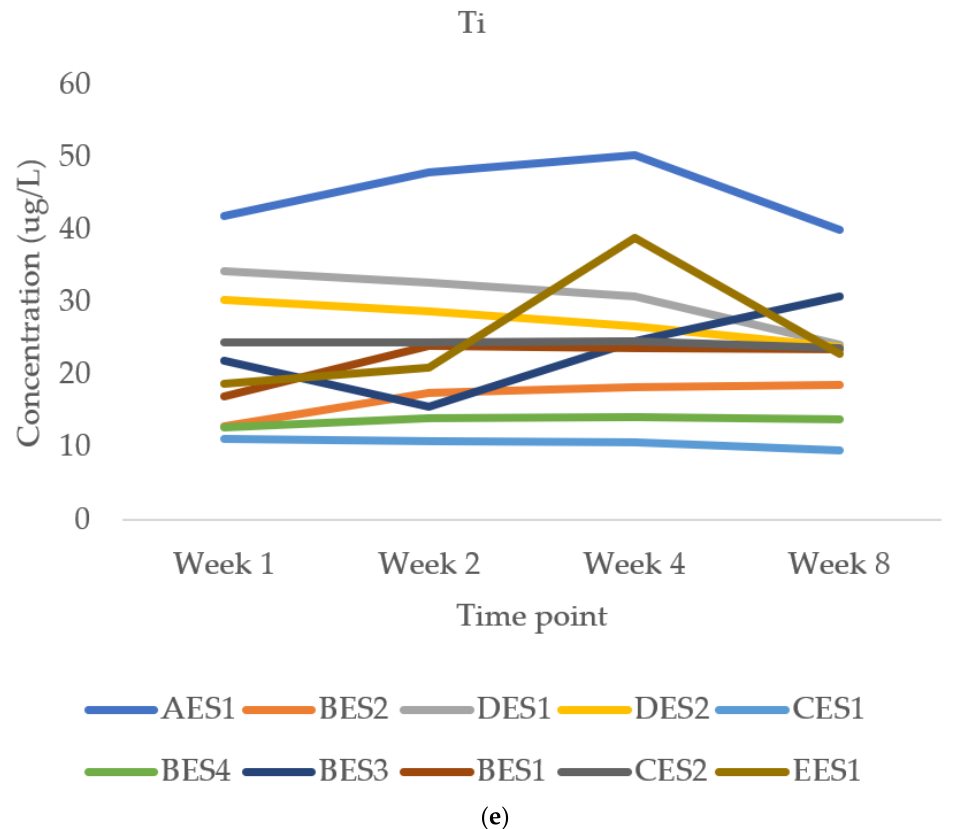
Figure 1. ( a ) Iron release ( μ g/L per gram of solid) from various ES at different timepoints; ( b ) Iron release ( μ g/L per gram of solid) at different time points, excluding AES1, BES2 and DES1; ( c ) Alu- minium release ( μ g/L per gram of solid) from various ES at different timepoints; ( d ) Manganese release ( μ g/L per gram of solid) for various ES at different time points; ( e ) Titanium release ( μ g/L per gram of solid) for various ES at different time points.